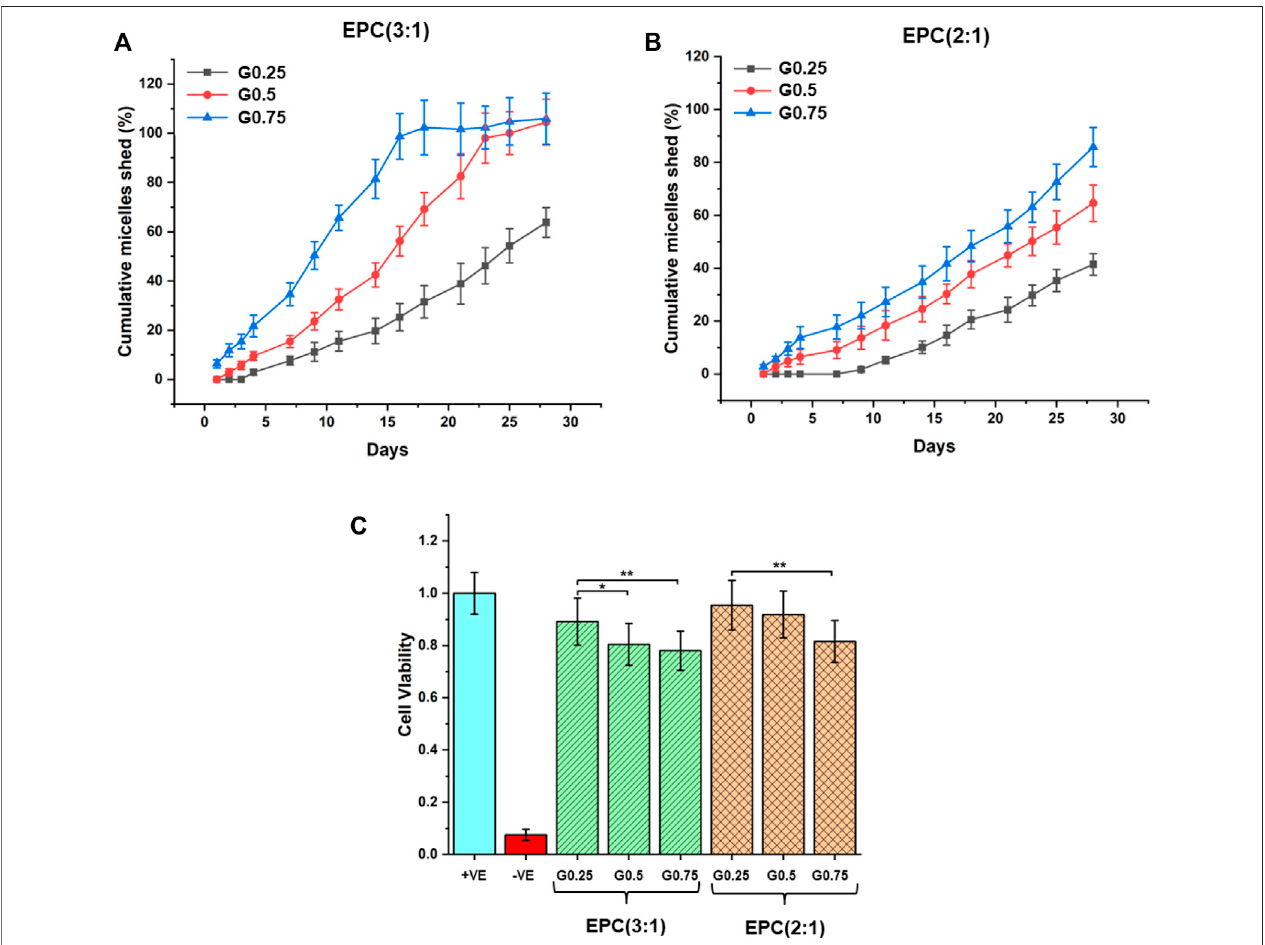
FIGURE 5 | In-vitro erosion pro fi les of (A) EPCG (3:1) and (B) EPCG (2:1) thermogels based on cumulative amount of micelles shed from bulk thermogels over 4 weeks. (C) Biocompatibility of the EPCG thermogels at 15 wt% after incubating them with NIH/3T3 cells for 72 h. In the positive control, cells were incubated with 1x PBS solution while in the negative control, cells were incubated with 1 v/v% sodium dodecyl sulfate (SDS) solution diluted using 1x PBS.